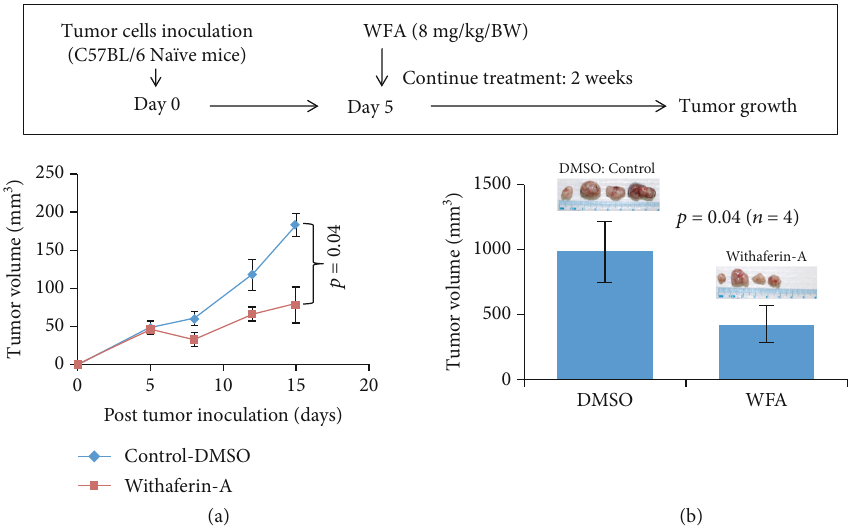
Figure 2: (a) WFA-induced activation of anticancer activity inhibiting the growth of established tumors in mice inoculated with RM1 mouse prostate tumor cells; (b) tumor volume on day 29. Six-to-seven-week-old, naive C57BL/6 mice were inoculated subcutaneously with RM1 tumor cells ( 5 × 10 5 ). Starting on day fi ve following tumor inoculations, a group of mice (4 mice/group) received an intraperitoneal (i.p.) injection of WFA (8 mg/kg/BW) fi ve days per week for two weeks. DMSO serves as the control at the same level ( v / v ) as for WFA treatment